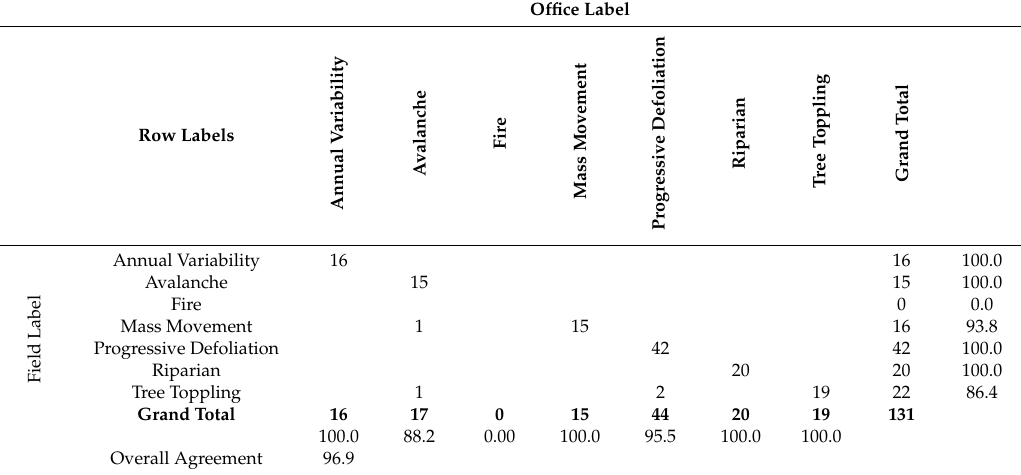
Table 3. Agreement matrix comparing primary and secondary labels assigned in office and field for the random sample